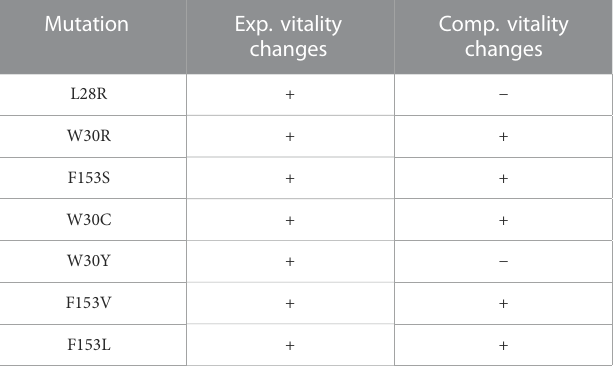
TABLE 2 Known resistance mutations involving active site positions. Mutation Exp. vitality Comp. vitality changes changes